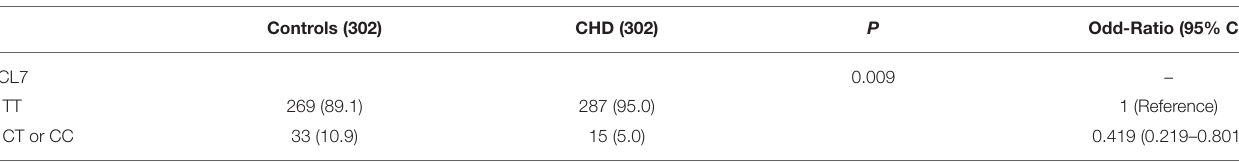
TABLE 5 | Conditional logistic regression for the CHD variable.